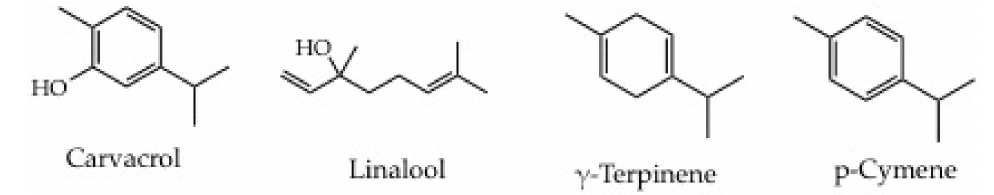
Figure 8. Main secondary metabolites produced by Satureja montana